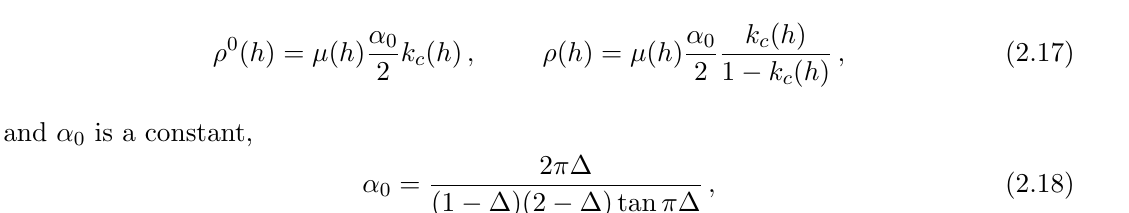
Figure 5. A pictorial representation of the four-point function, split into a product of two three- point functions h (cid:31)(cid:31) Oi , see [13], using the shadow formalism. See eq. (2.12).